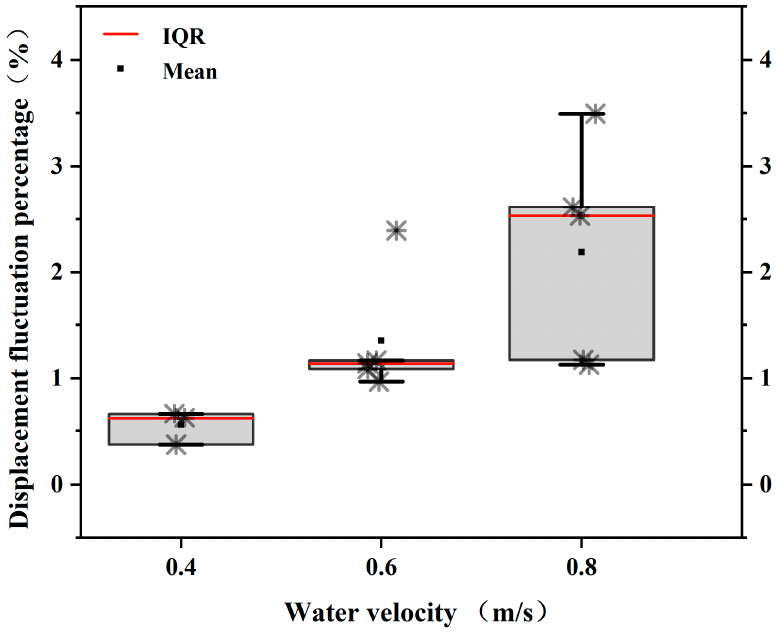
Figure 7. Relationship between thrust and water flow velocity in steady/unsteady mode of Schizo- pygopsis malacanthus swimming. Note: IQR: Interquartile range.